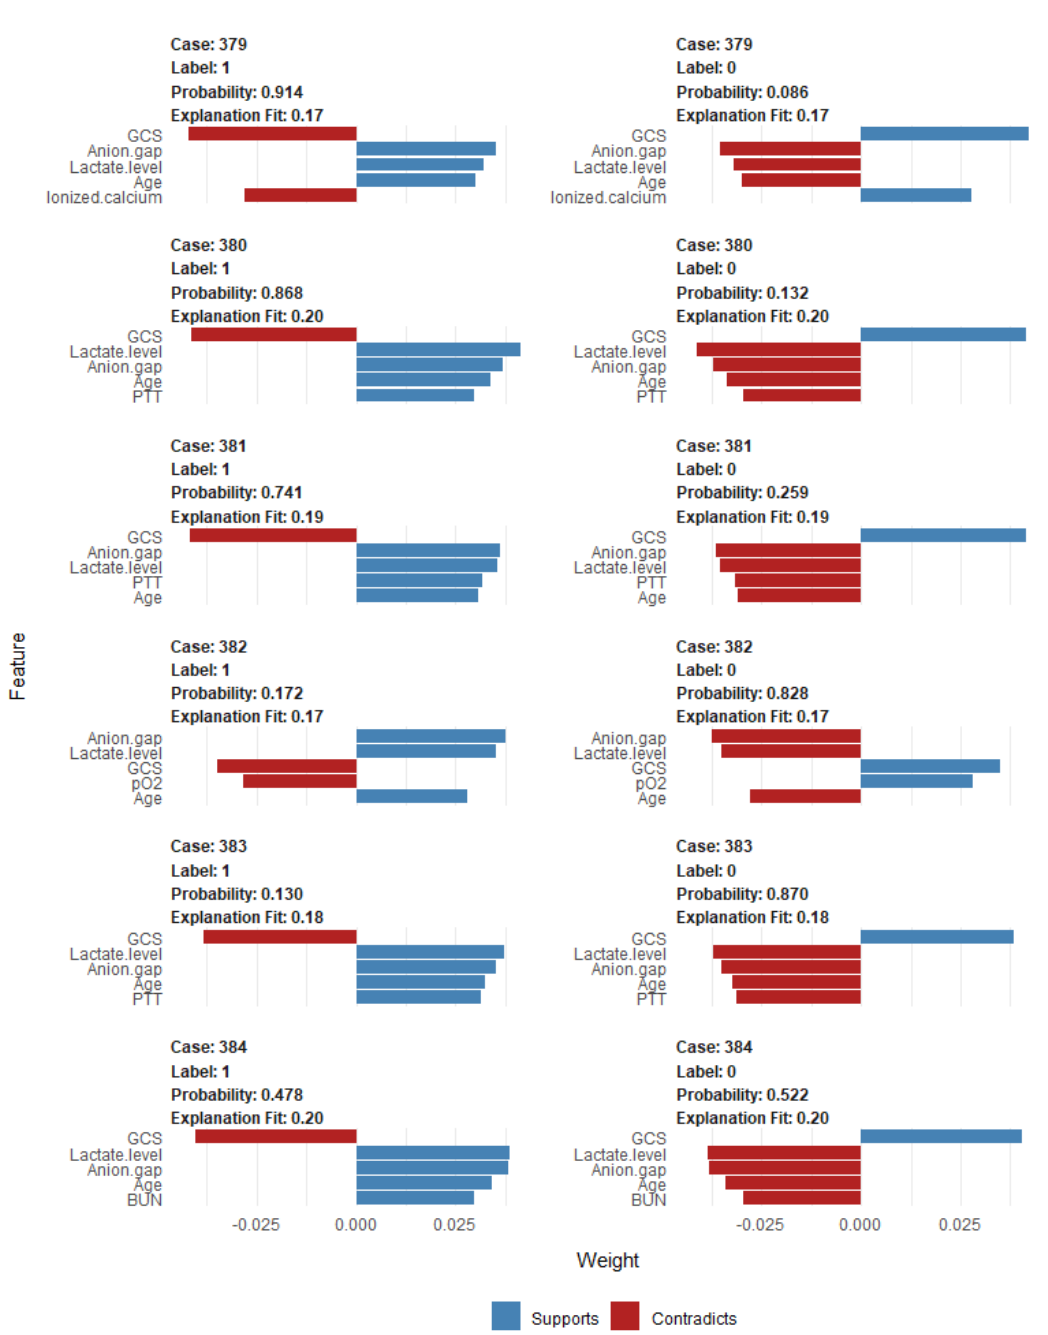
Figure 5. Local interpretable model explainer (LIME) for 6 individual cases (case# 379 to 384) from the testing dataset. Label “1” means prediction of mortality and label “0” means prediction of no mortality (survival). Probability shows the probability of the observation belong to the label “1” or “0”. The five most influential variables that best explain the linear model in that observation’s local region are provided and whether the variable causes an increase in the probability (supports/blue bar) or a decrease in the probability (contradicts/red bar). The x-axis shows how much each feature added or subtracted to the final probability value for the patient. Abbreviations: BUN, blood urea nitrogen; GCS, Glasgow Coma Scale; PTT, partial thromboplastin time; pO2, partial pressure of oxygen.